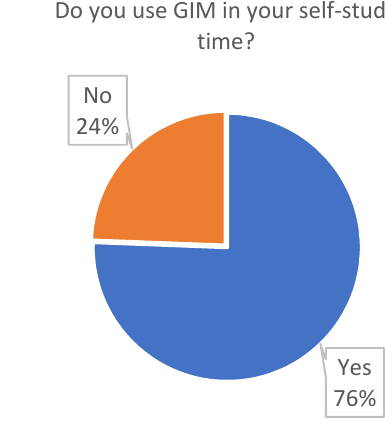
Figure 23. Use of GIM in the learning process.